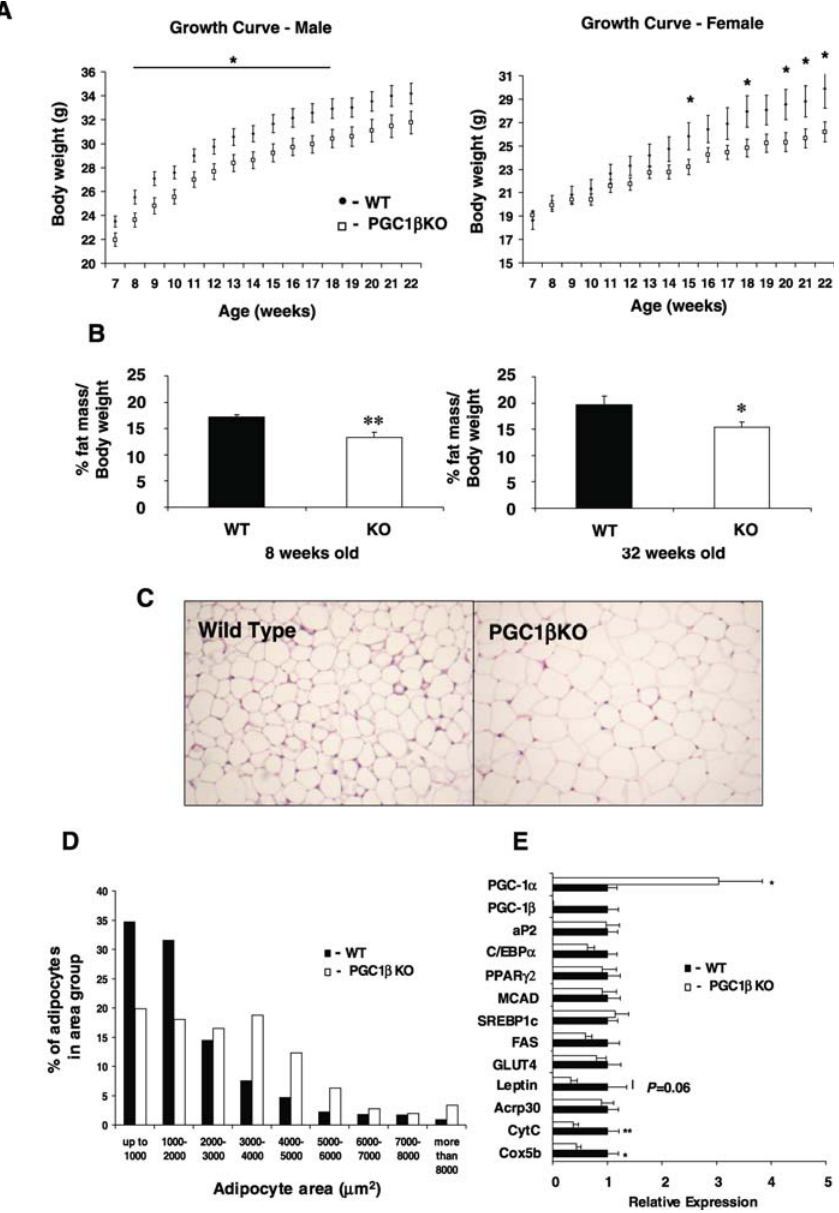
Figure 2. The PGC1 b KO Mouse Has Altered Metabolism under Standard Environmental Conditions (A) Growth curves of male (left panel) and female (right panel) mice on normal diet. WT (solid circles) and PGC1 b KO (open circles) mice, n ¼ 18–21 mice per group. (B) Assessment of fat content by DEXA in 8- and 32-wk-old male WT (solid bars) and PGC1 b KO mice (open bars), n ¼ 8–12 mice per group. (C) Representative histological sections of tissues from WAT ( n ¼ 6). (D) Size distribution of adipocytes from WT and PGC1 b KO mice. Two fields from each section from epididymal adipose tissue depot ( n ¼ 4 mice per genotype) were analysed to obtain the mean cell area per animal. (E) Epididymal WAT gene expression from 12-wk-old PGC1 b KO (white bars) and WT littermates (black bars). Individual measurements are standardized using 18S, and then the average of the WT group was set to 1. n ¼ 5–8 mice per group. DOI: